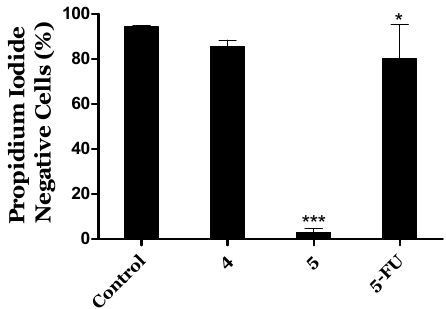
Figure 4. Percentage of viable HepaRG cells treated with steroids 4 and 5 (50 µ M, for 24 h) by flow cytometric assay with propidium iodide (PI) staining. Untreated cells were used as the control. The percentage of cells in R1 (live cells, PI negative) as compared to the total number of events in R1, R2 (dead cells), and R3 (undetermined cells) was considered the percentage of viability. Each bar represents the mean ± SD (originated from two independent experiments). * p < 0.05; *** p < 0.001 vs. control (two-way ANOVA post-hoc Bonferroni test).